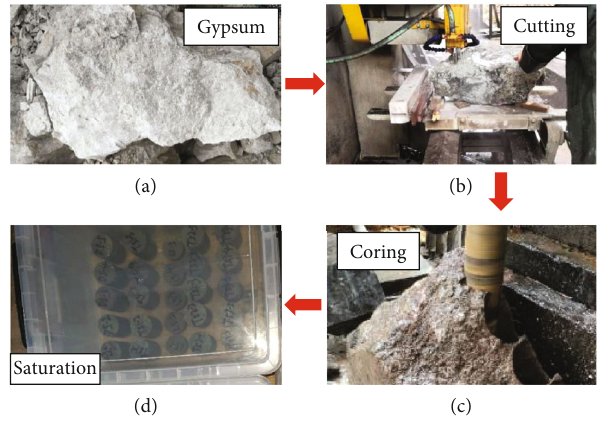
Figure 2: Gypsum